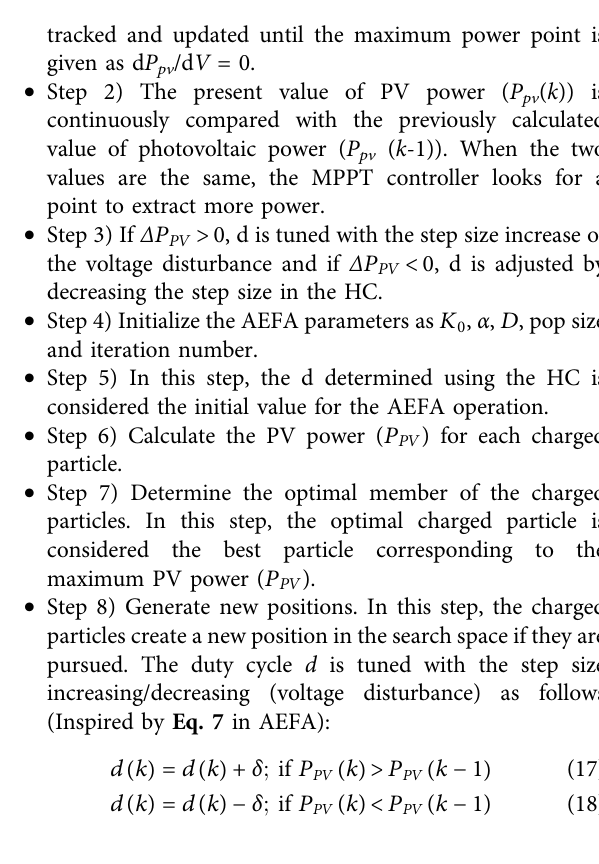
Frontiers in Energy Research |